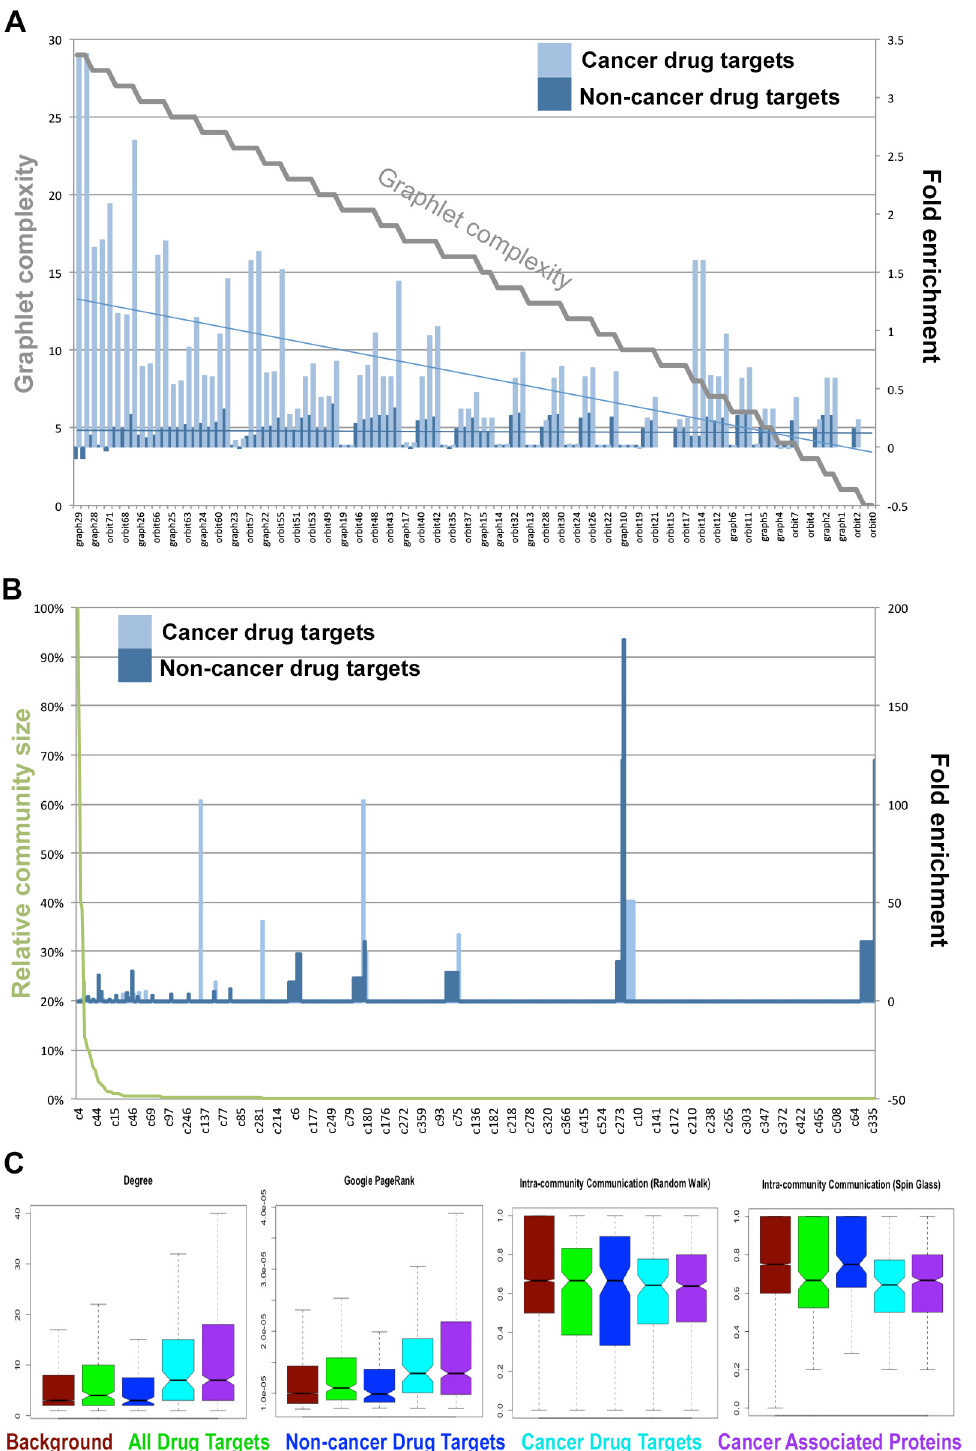
Fig 1. Enrichment and depletion of key parameters in drug targets over what can be expected at random from the interactome. A) Graphlets and their constituent isomorphism orbits. The graph shows the graphlets and orbits, ordered by descending size and complexity, most enriched in cancer-drug targets (light blue bars). These same graphlets and orbits are either slightly depleted or not differentiated from random in targets of non-cancer drugs (dark blue). The gray line represents graphlets size and complexity (high-to-low). B) The distribution of detected community sizes and the enrichment or